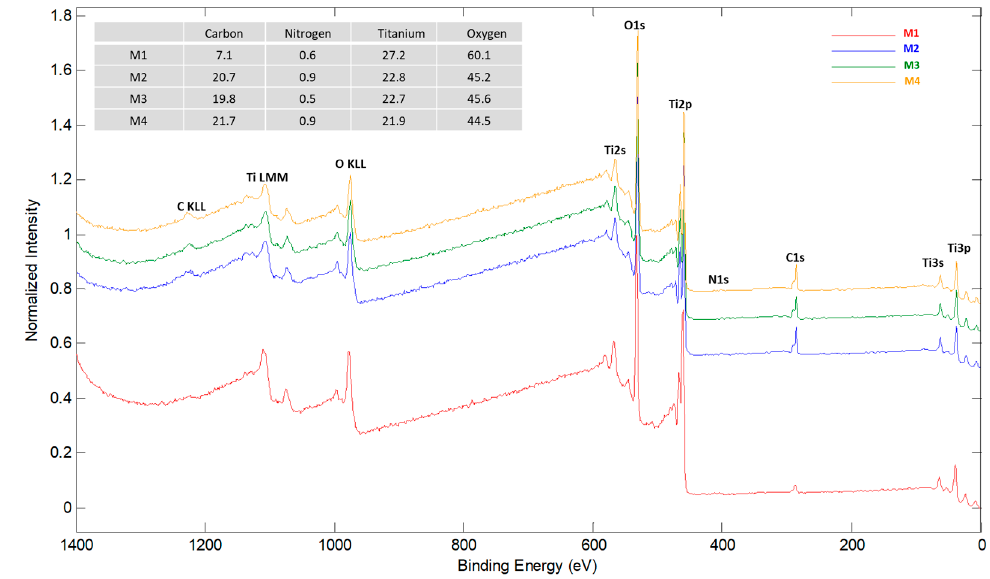
Figure A1. X-ray photoemission survey spectra of M1, M2, M3, and M4 layers with associated percentage atomic concentrations per element as displayed in the embedded table. Auger and XPS peak identification appear in bold black letters.